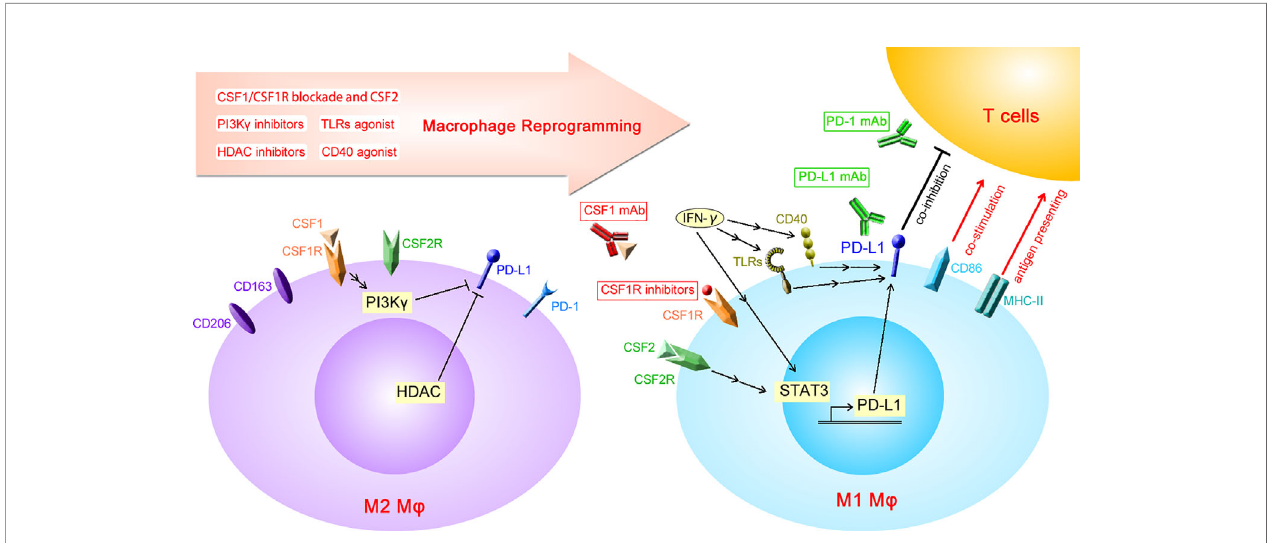
FIGURE 1 | Diagrammatic sketch of macrophage reprogramming increasing the expression of PD-L1. PD-L1, programmed death-ligand 1; PD-1, programmed cell death protein 1; CSF1, colony-stimulating factor 1; CSF1R, CSF1 receptor; CSF2, colony-stimulating factor 2; CSF2R, CSF2 receptor; HDAC, histone deacetylase; IFN- g , interferon- g ; TLRs, toll-like receptors; MHC-II, major histocompatibility complex-II; mAb, monoclonal antibody; M j ,